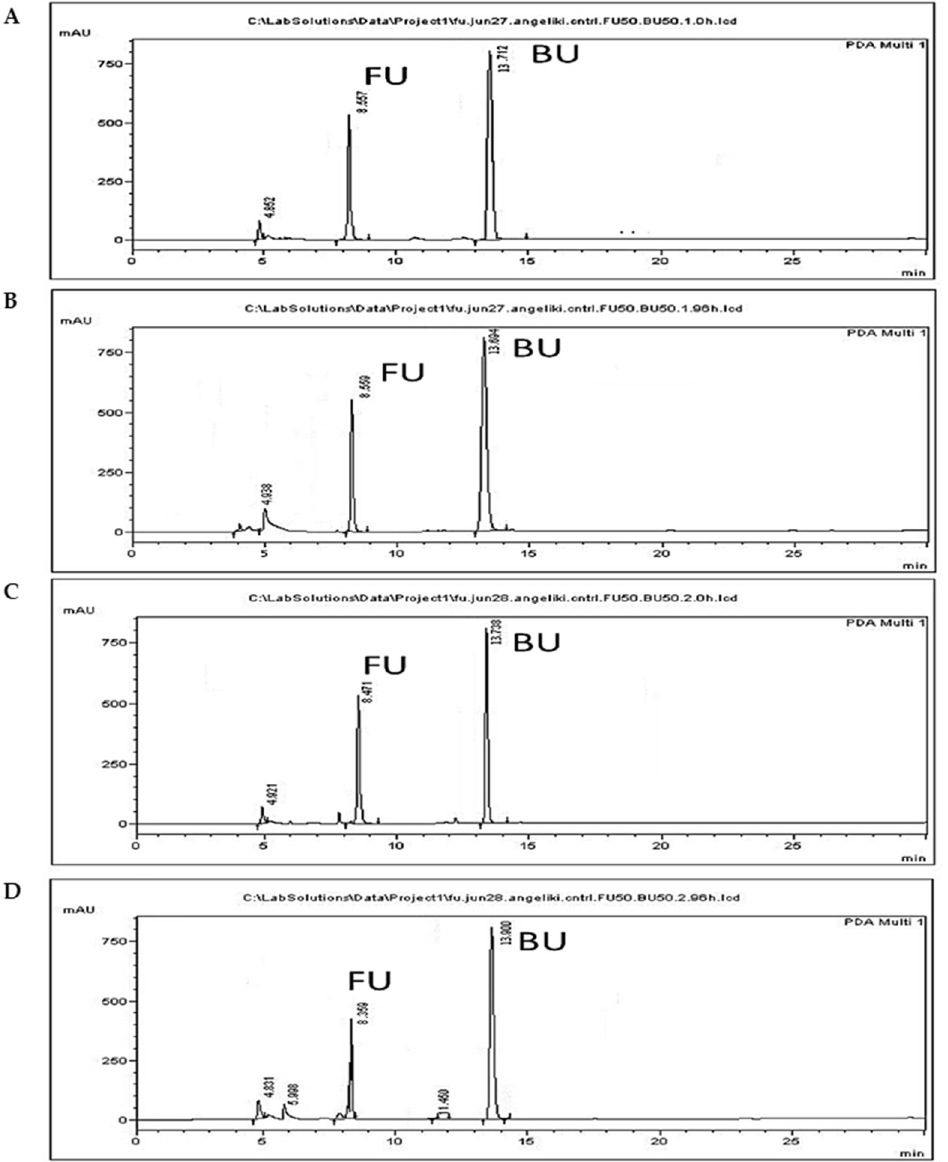
Figure 4. Photodegradation of 5-FU. Representative chromatograms from 5-FU (FU) (50 μ g/mL) incubation in the dark at 0 h ( A ) and 96 h ( B ), and under normal light at 0 h ( C ) and 96 h ( D ). The levels of 5-FU in the medium (Figure 3C) were determined to be 49.5 μ g/mL at the onset of the experiment and 5.2 μ g/mL at the end (Figure 5B); that is a reduction of 89.5%. These values correspond to 156 μ g in total culture volume (30 mL), and added to the 5-FU levels in the cells (Table 2), they produce a sum of 182.2 μ g 5-FU, a value which is quite lower than the originally added nominal amount of 50 μ g/mL of 5-FU or the determined amount of 1485 μ g in total culture volume.